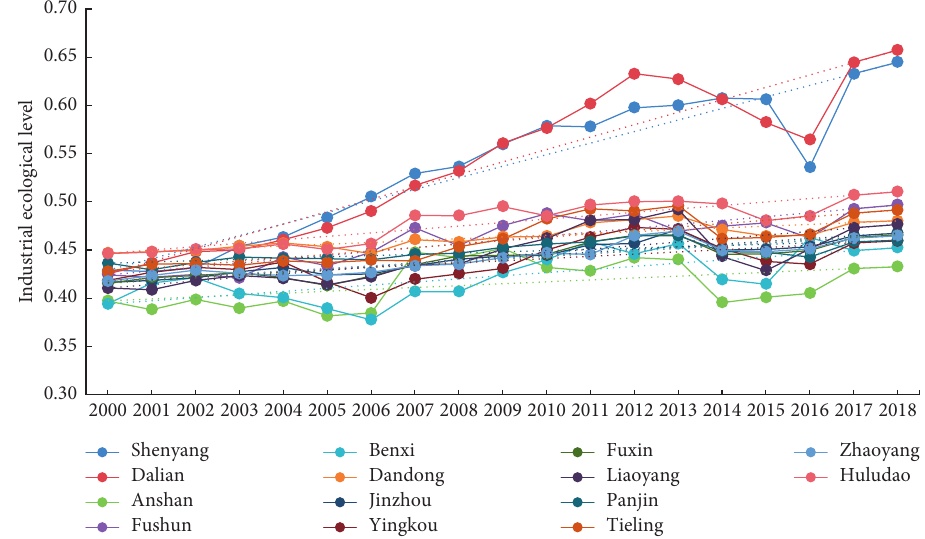
Figure 2: Development levels of industrial ecosystems in the 14 cities of Liaoning Province